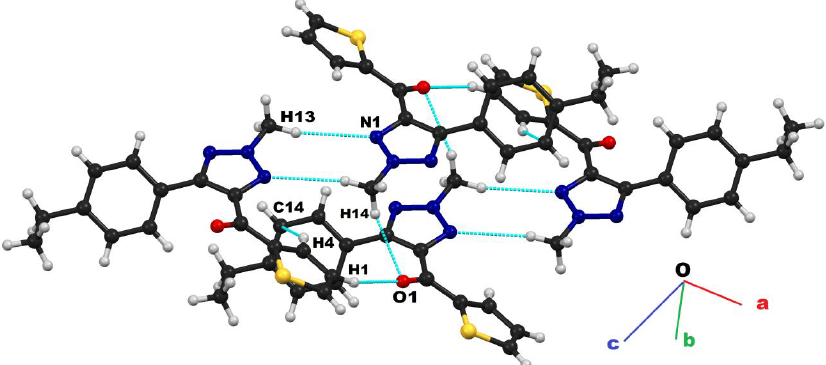
Figure 5. Centro-symmetric C-H···N dimers connected via C-H···O and C-H···π interactions. Table 1. The antifungal activity of 5-(substituted phenyl)-2-methyl-2 H -1,2,3-triazol-4- yl(4-substitutedphenyl / thiophenyl) methanone analogues (GKV1-15).